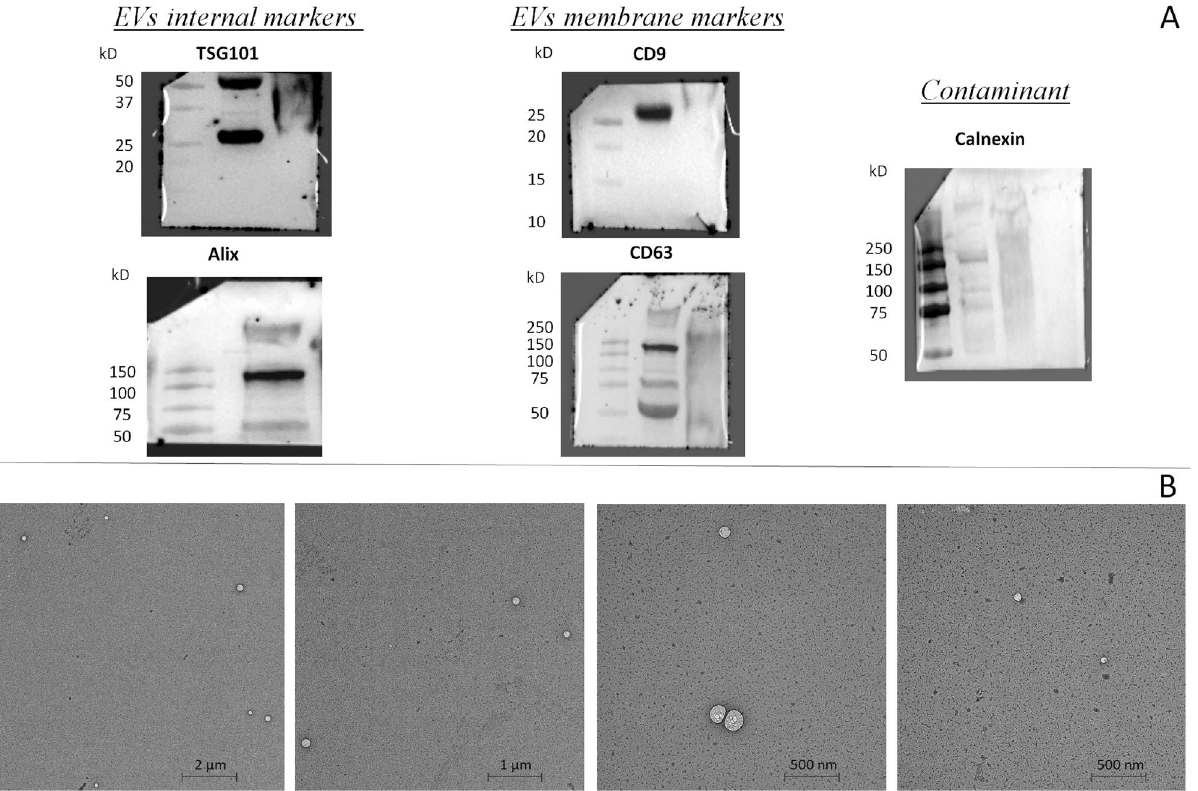
Figure 1. EVs isolated (pool of FF collected in An and pO follicles in both seasons) were characterized by: ( A ) Western Blot for EVs internal markers (TSG101 and Alix), membrane markers (CD9 and CD63); and Calnexin as marker of cell contamination in EVs preparation. ( B ) Transmission Electron Microscopy that revealed typical morphologies characteristic of vesicle (scale bar: from 500 nm to 2